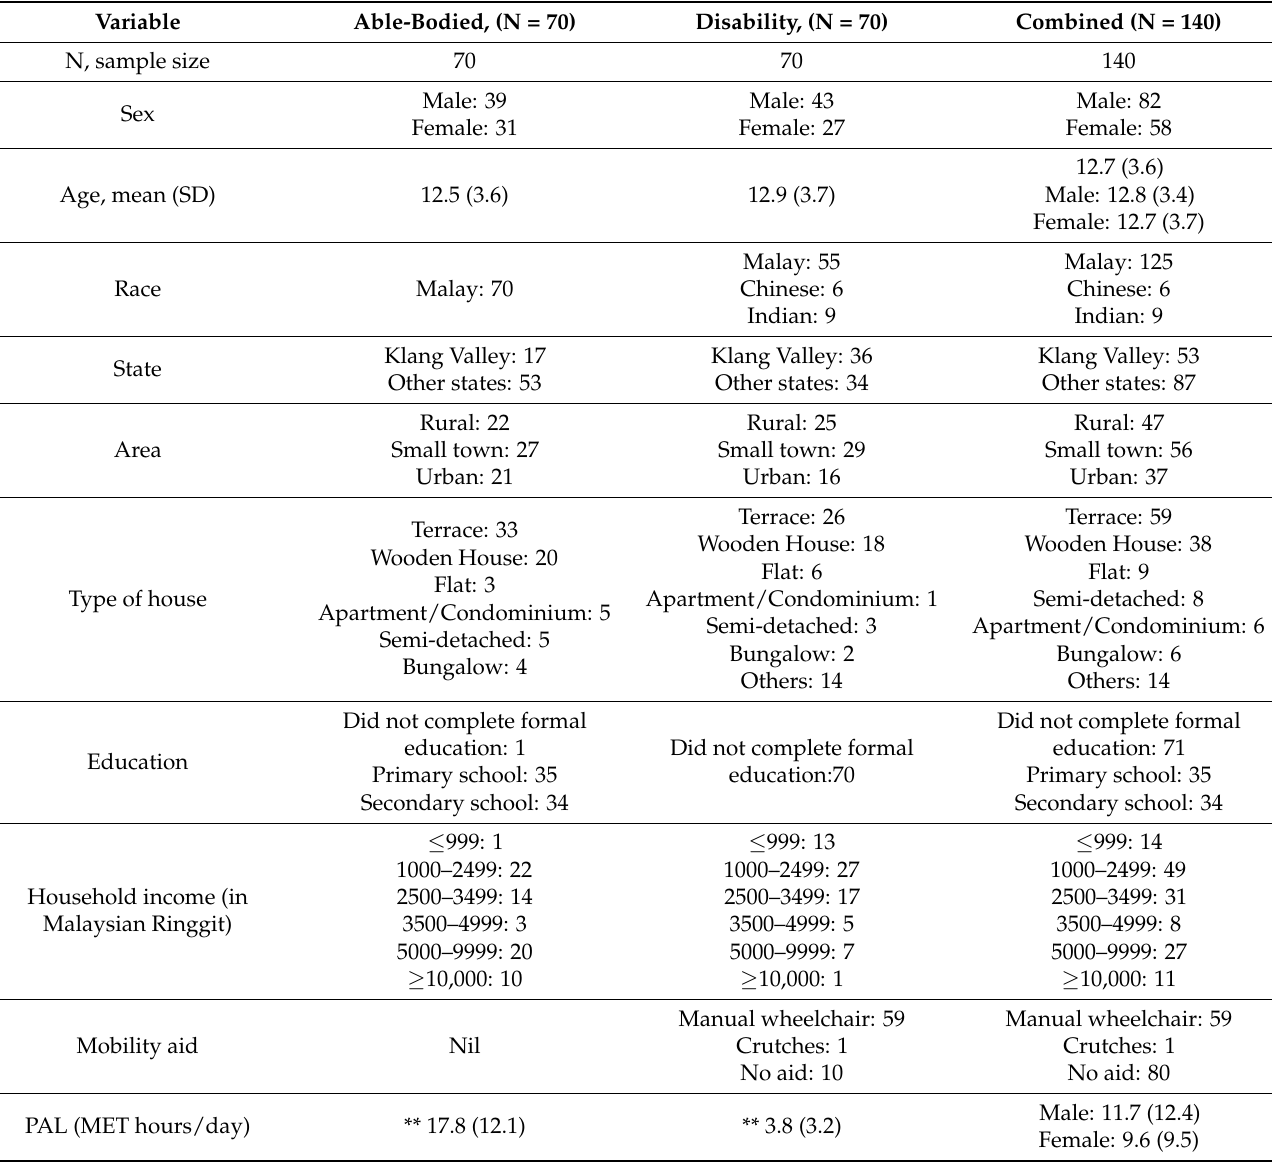
Table 1. Demographic profiles of respondents, N =